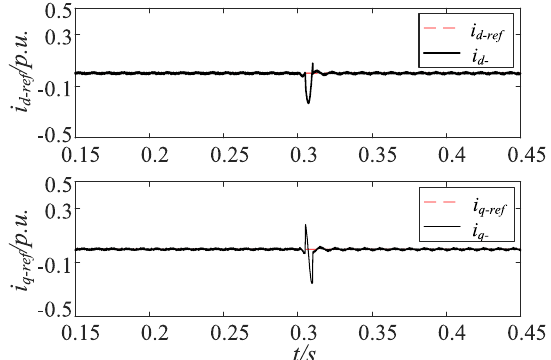
Fig. 19 Negative sequence dq -axis current when the voltage drops under full load condition